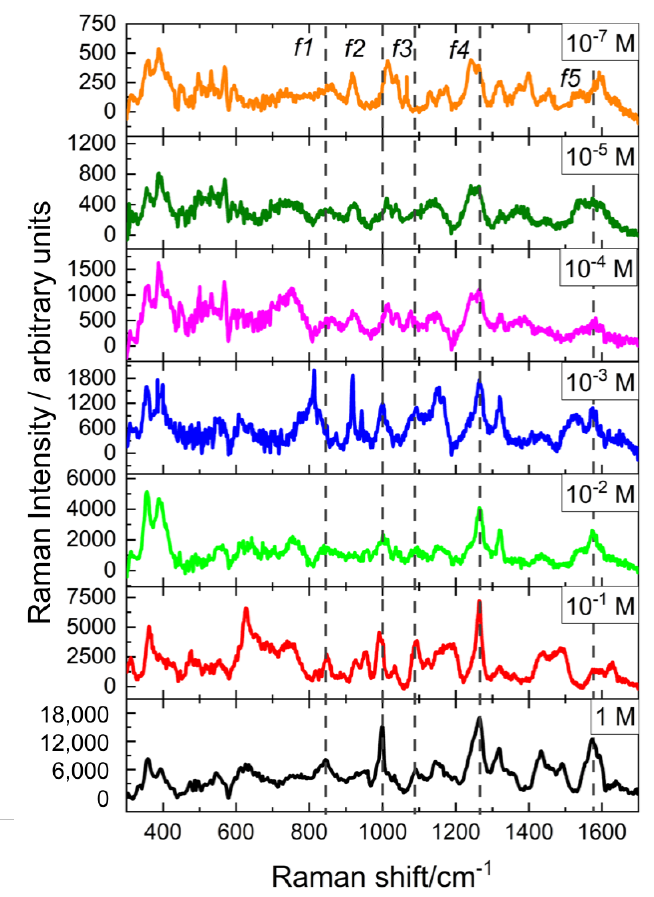
Figure 4. Raman spectra of the vibrational resonances of the histamine dication molecule at several concentrations. All the solutions include gold nanoparticles. Dashed vertical lines corresponde with characteristic peaks of the histamine molecule. Figure 5 will focus our attention on the f 4 resonance around κ = 1265 cm − 1